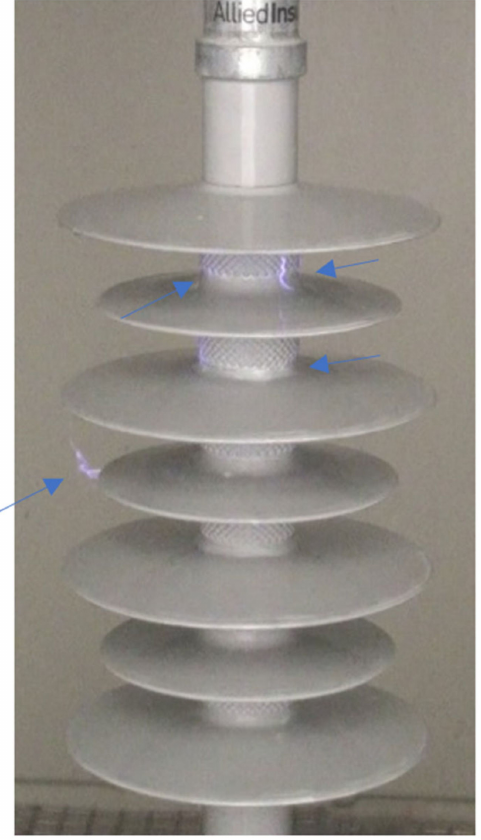
Figure 8. Visual image of Dry Band Discharges (DbD) on the insulator surface with light pollution at 70 kV rms.